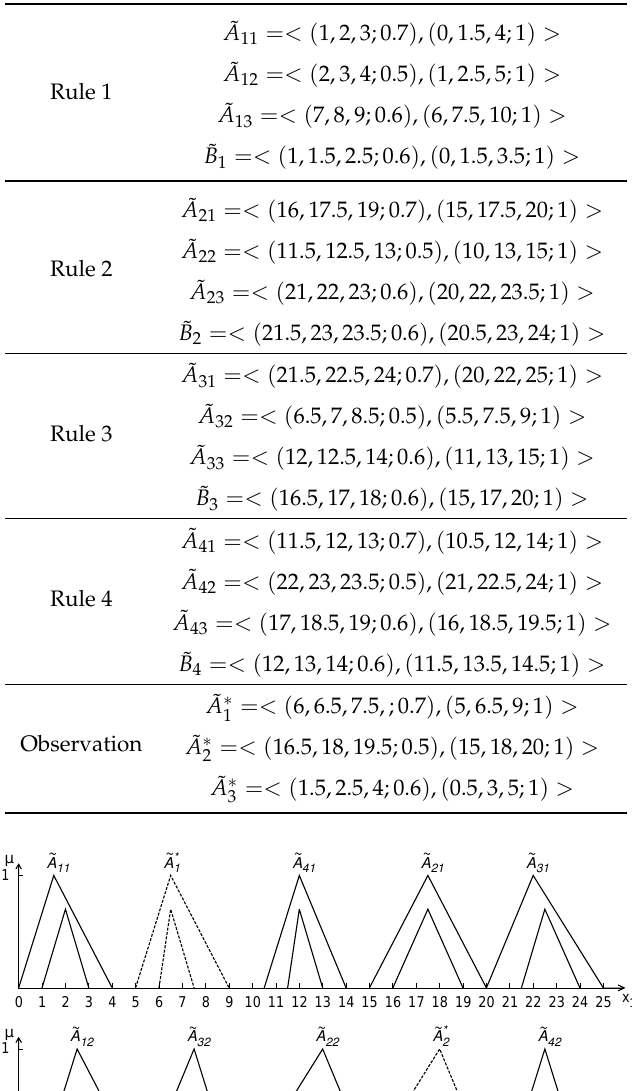
Table 3. Hybridisation of interpolation and extrapolation for Case 3.